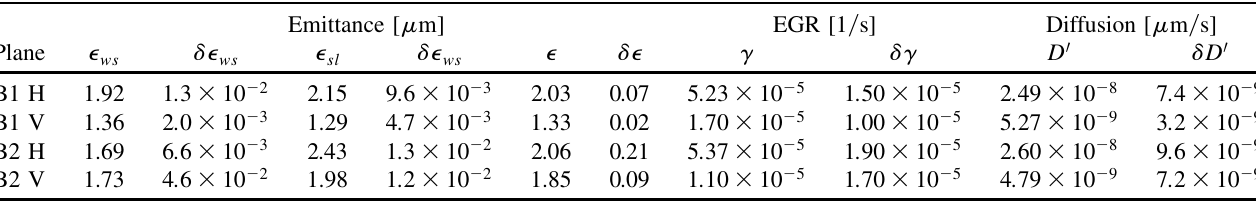
TABLE VI. Initial emittances (wire scan, synch-light, average), emittance growth rates (EGR) (cid:6) , and diffusion slopes D 0 . Plane